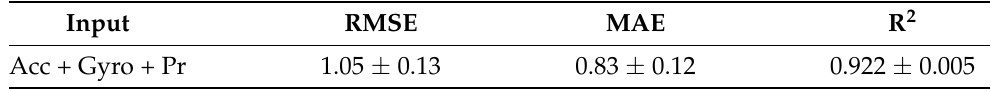
Table 1. EE (KCal/min) estimation